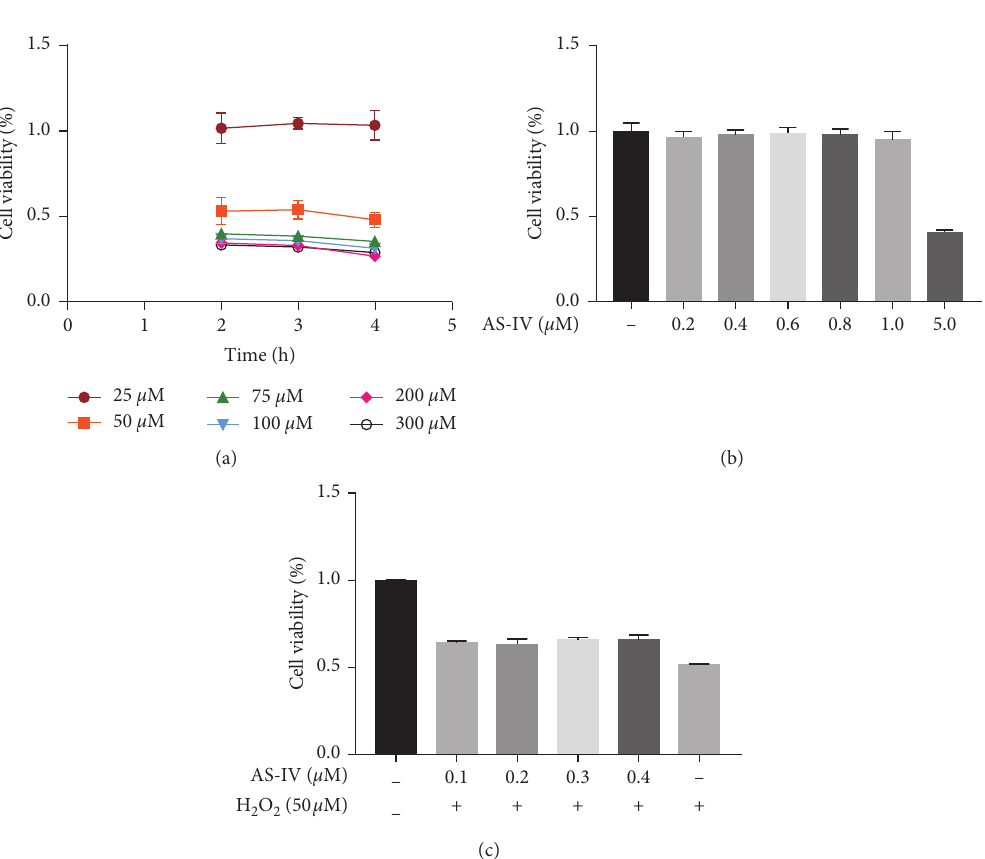
· L − 1 ) for 2, 3, and 2 O 2 (25 ∼ 300 μ mol